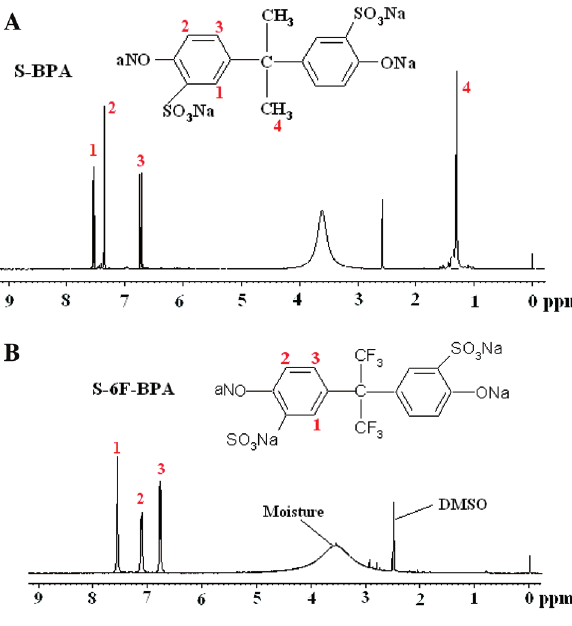
Figure 2: 1 H NMR spectra of (A) S-BPA and (B) S-6F-BPA.